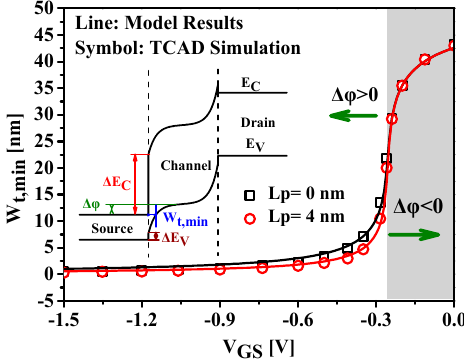
Figure 6. Shortest tunneling distance versus gate voltage. The pocket doping density for HSP-TFET is 1 × 10 19 cm − 3 . The gate work function is 4.7 eV and the drain bias is 0.5 V.